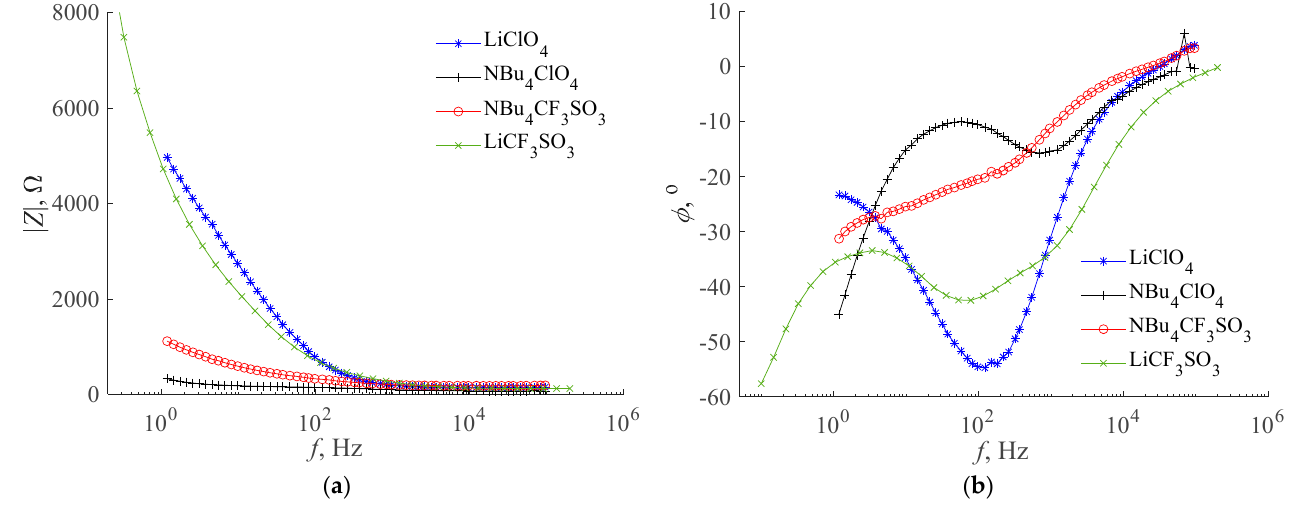
Figure 8. Measurement frequency characteristics of: ( a ) modulus and ( b ) argument of impedance of the tested symmetric supercapacitors with collectors containing polypyrrole.